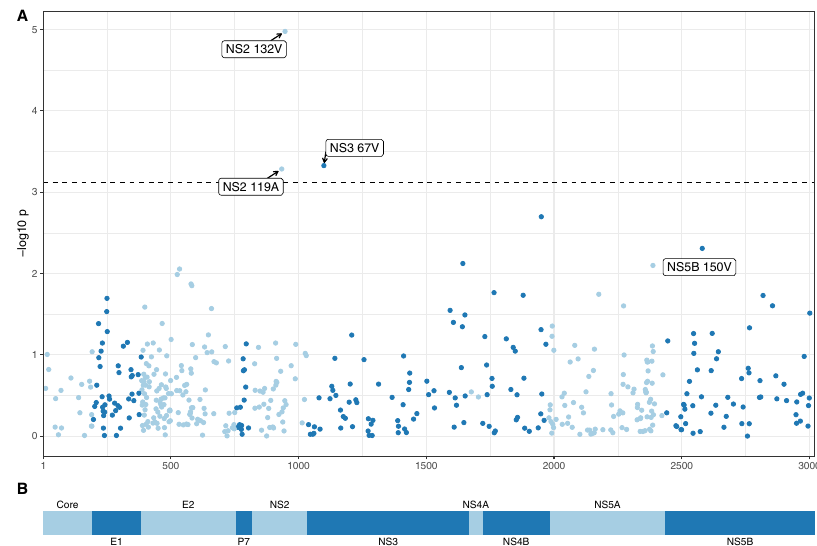
Fig. 1 Association between hepatitis C virus (HCV) amino acids and sofosbuvir-based treatment outcome. A Manhattan plot of association tests between HCV amino acids and treatment outcome. At each viral site only the p-value for the most associated amino acid is plotted. The dashed line indicates 15% false discovery rate. For the three sites signi fi cantly associated with outcome and the most associated site in the non-structural 5B (NS5B) protein, the amino acid associated with the lowest cure rate at the site and its position within its respective protein is indicated. B Schematic of HCV